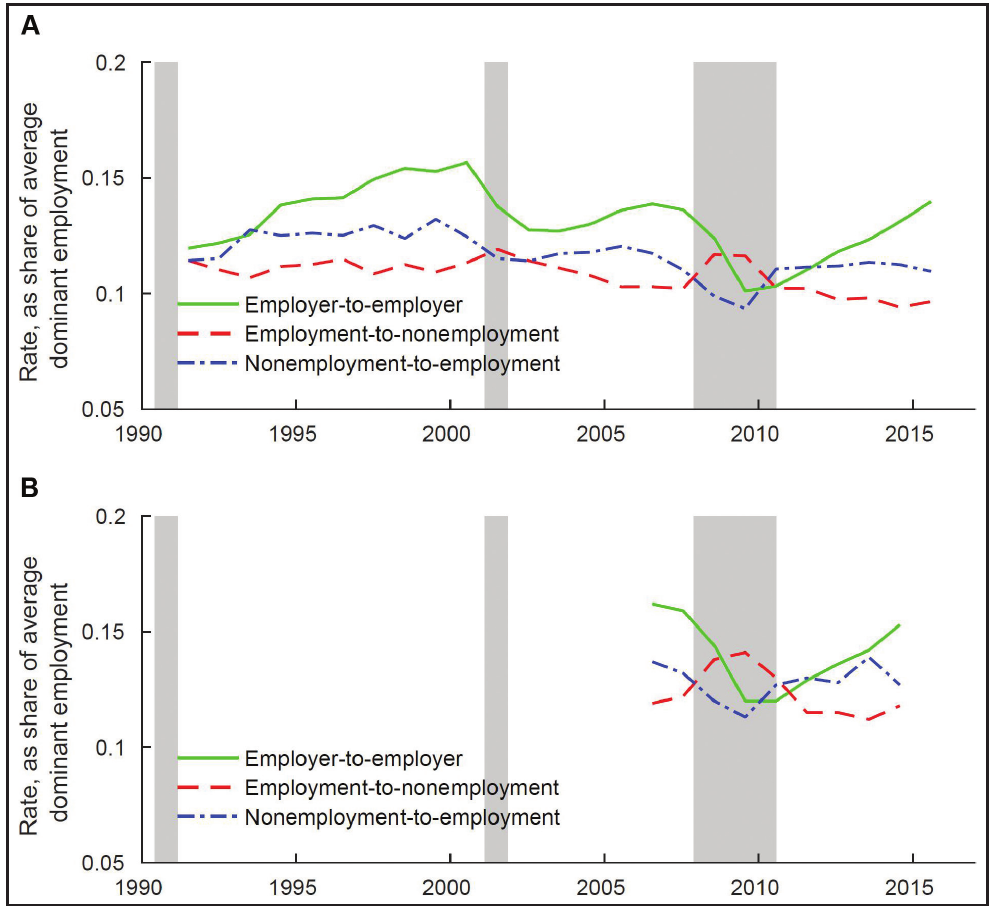
Figure E3 Employer-to-employer and nonemployment